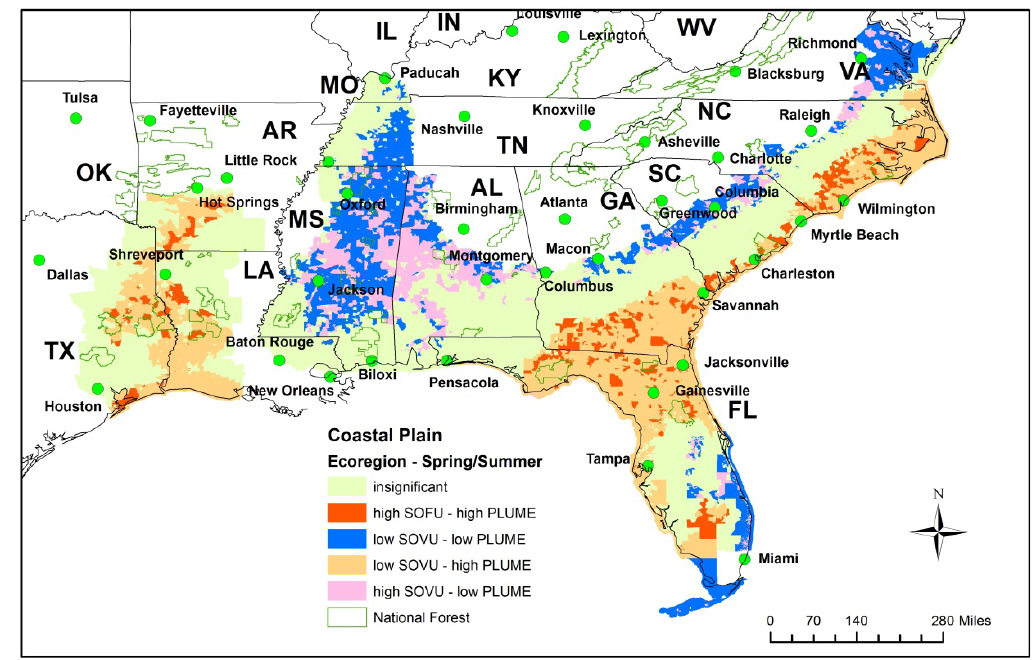
Figure 9. Bivariate LISA mapping of social vulnerability and smoke plume in the Coastal Plain